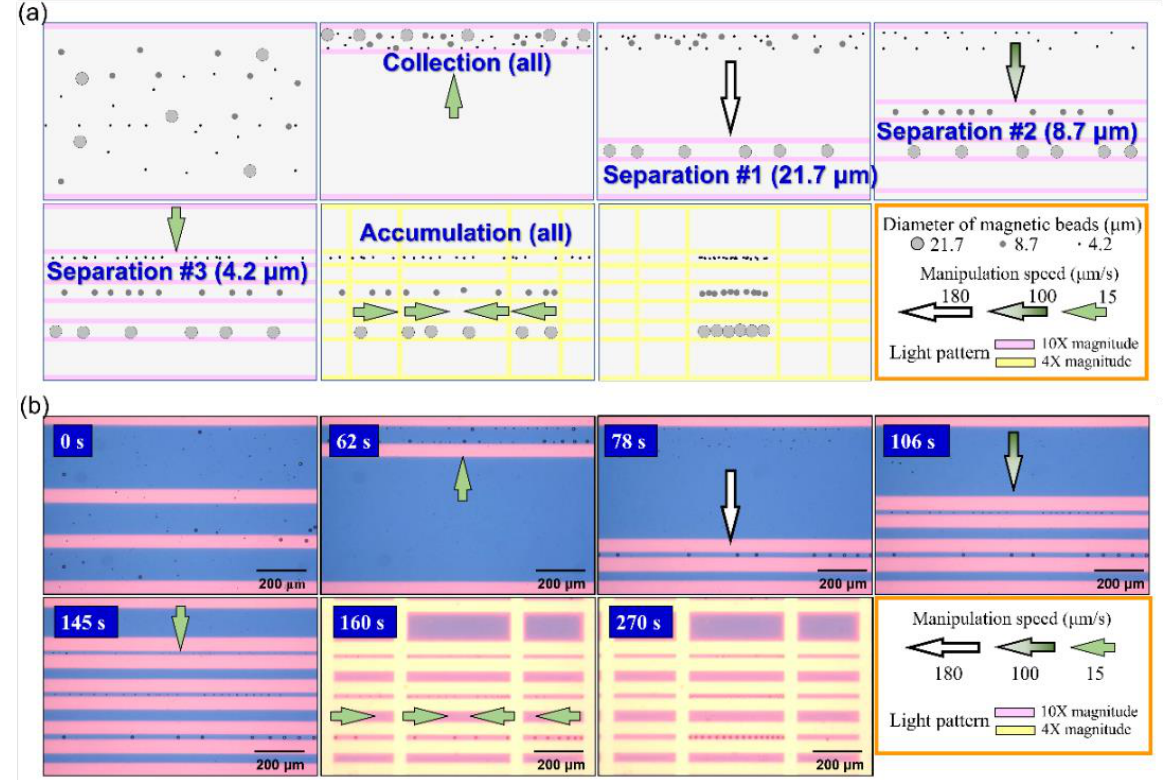
Figure 7. ( a ) The schematic plot and ( b ) real images captured from video of multiple manipulations including collection, separation, and accumulation of magnetic beads with three different diameters to form tunable and concentrated transducer elements for fluorescence enhancement. To collect more magnetic beads to form three transducer elements, all with a higher intensity, a wide collection area of light pattern is obtained by changing an object lens with magnification from 10 × to 4 × , as shown in the images captured at 160 and 270 s.